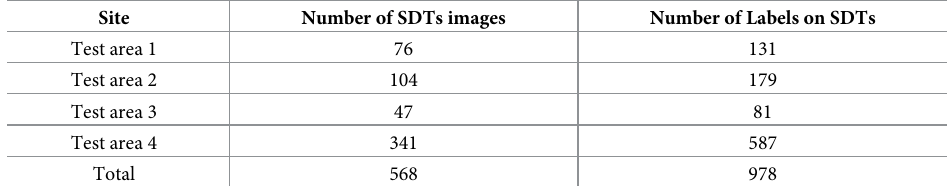
Table 2. The number of SDTs in the test area.